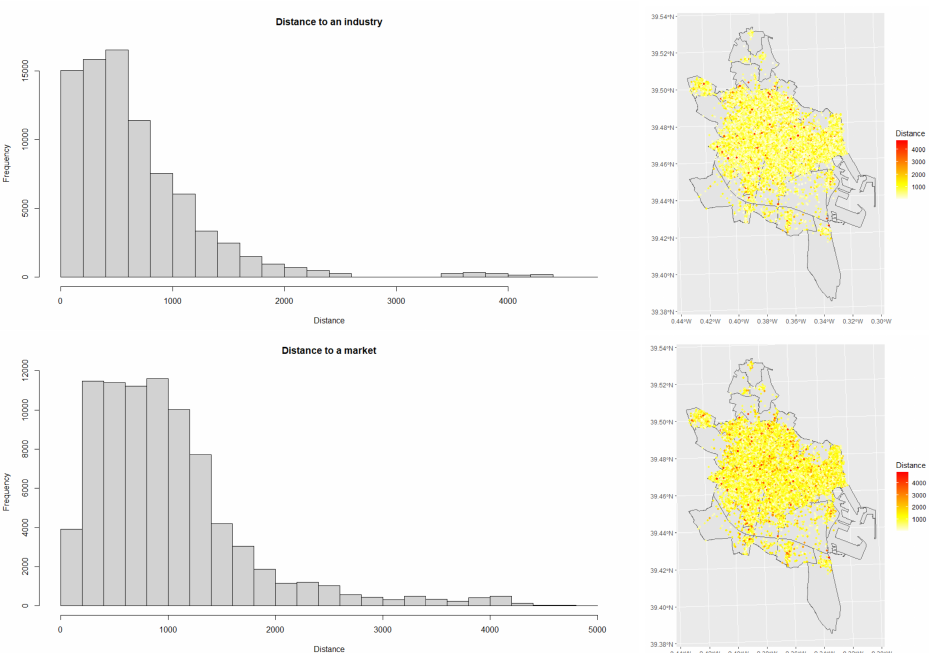
Figure 10. Histogram and corresponding point patterns coloured by their minimum distances to industries (top row) and to markets (bottom